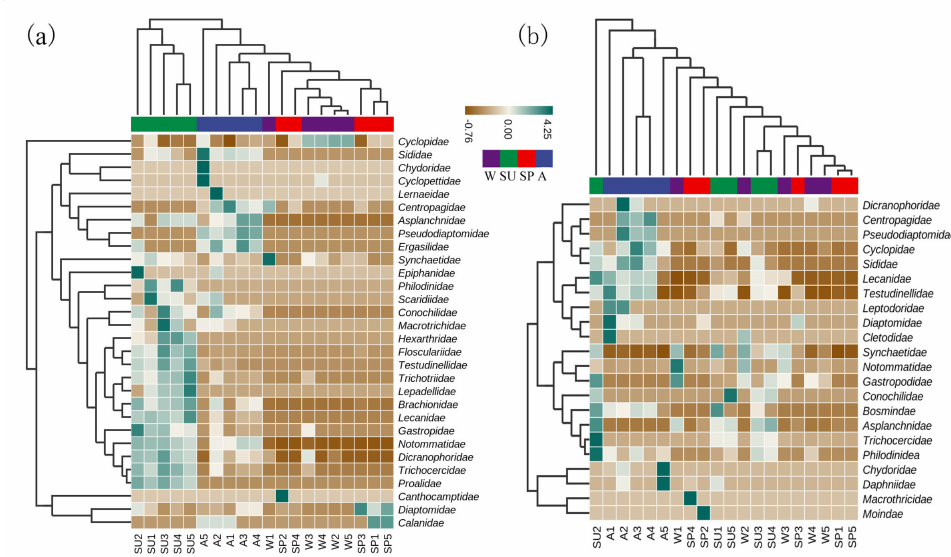
Figure 5. Cluster heat maps of family by MOI and MBC. ( a ) MBC; ( b ) MOI. A: autumn; SP: spring; SU: summer; W: winter. Numbers 1, 2, 3, 4, and 5 are the sample